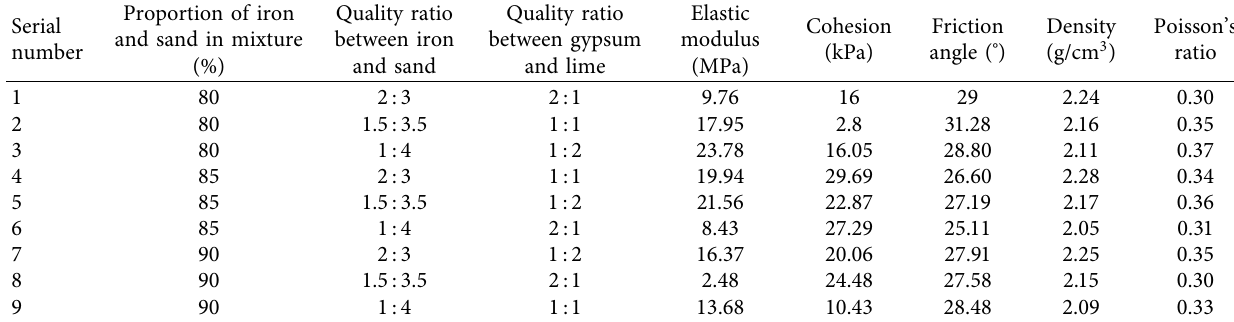
Table 8: Orthogonal test conclusion.